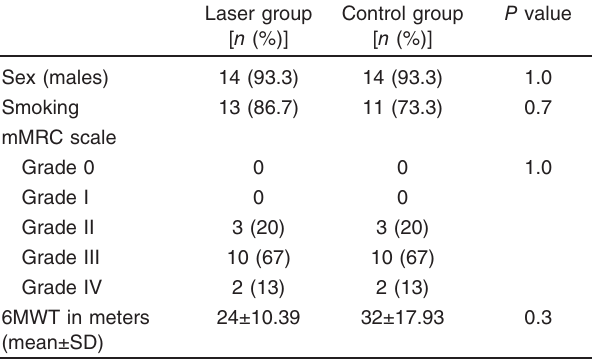
Table 1 Baseline clinical data in both groups